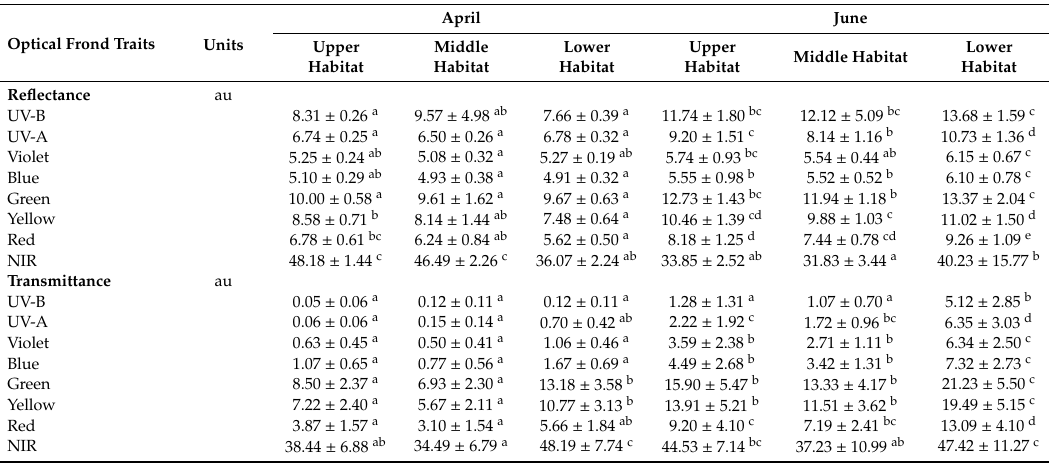
Data are means ± SD (n = 10 for each column). Different superscript letters within each row indicate significant differences ( p ≤ 0.05; Duncan tests). Reflectance and transmittance spectra represent means within 5-nm intervals ( p ≤ 0.05, Duncan tests). NIR, near-infrared; au, arbitrary units.